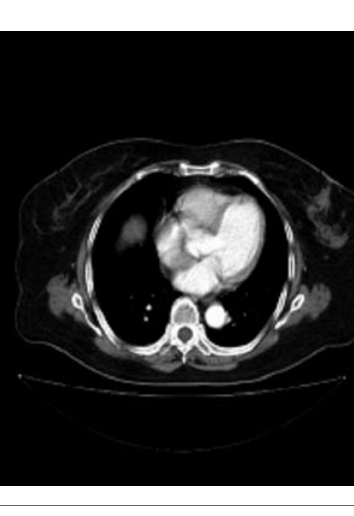
Figure 2. Computerized tomography. Figure 3. Histological picture of gastric mantle-cell lymphom. Magnification x 40. A) Diffuse wall thickening of the gastric tumor cells show nodular and diffuse infiltration of gastric mucosa; B), C) and D) tumor antrum, which is in direct contact with the cells are positive for CD20, ciklinD1 and CD5 antigen; E) and F) tumor cells are negative wall of duodenum and suppresses pan- for CD3 and creas.